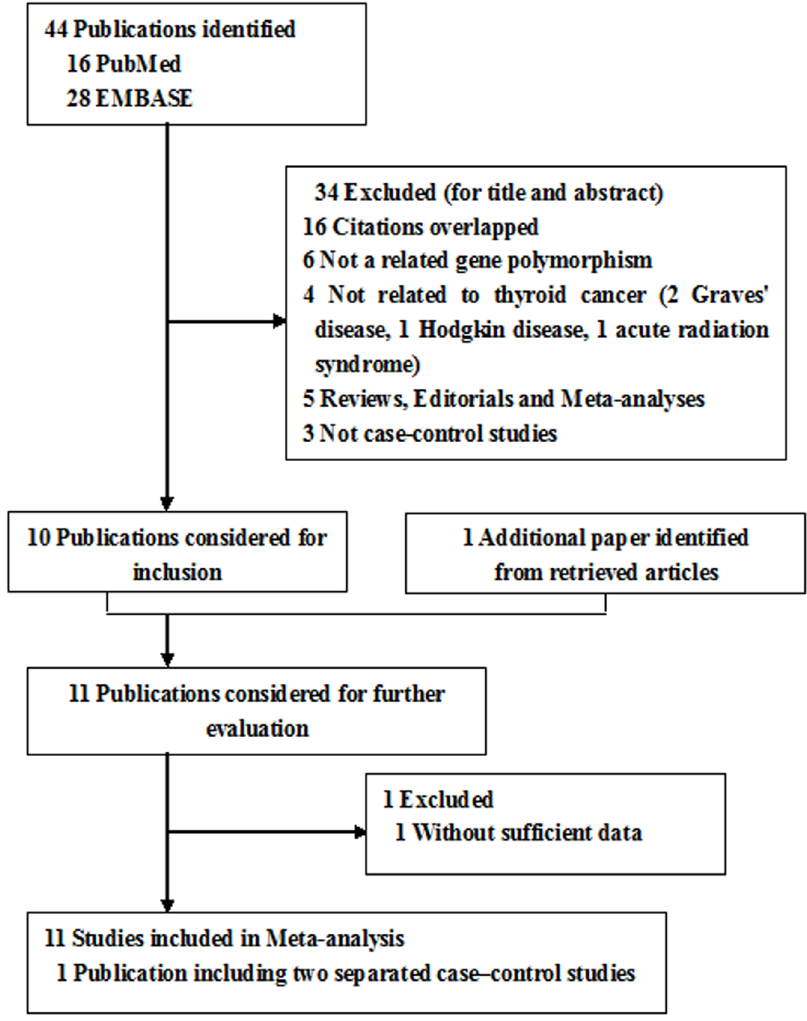
Figure 1. Flow diagram of included studies for this meta-analysis.